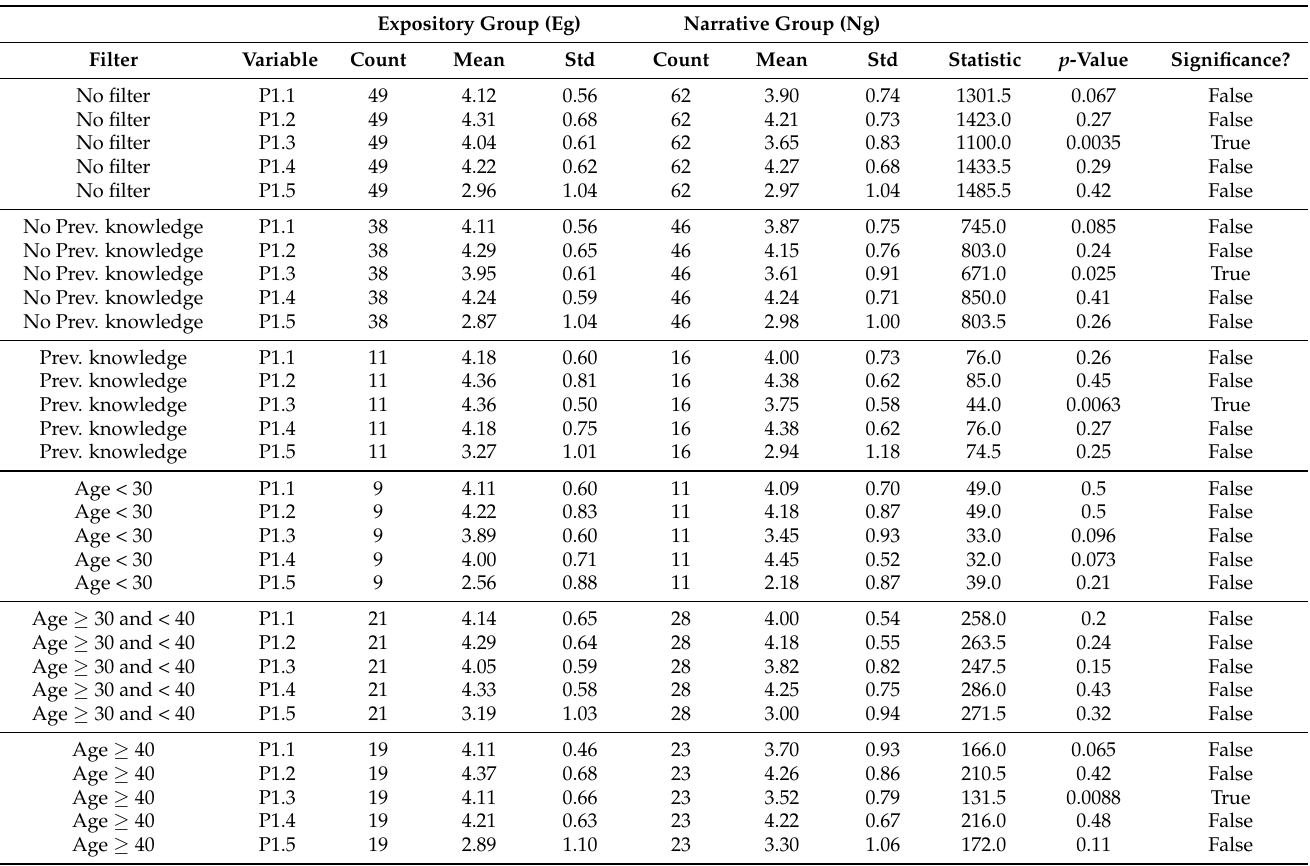
Table 2. Results of the Mann–Whitney U test of the variables related to the format of the learning resources. Expository Group (Eg) Narrative Group